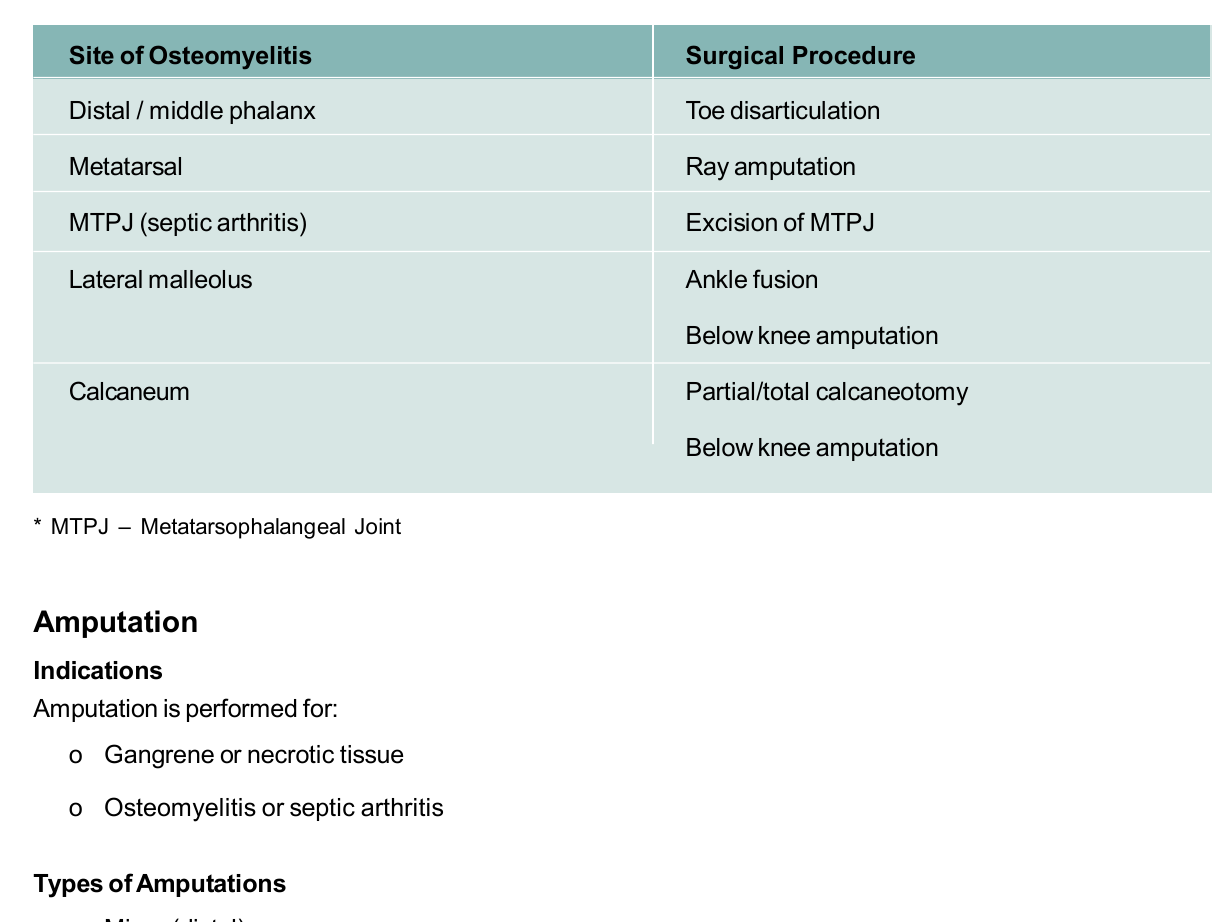
Table 6. Types of Surgery for